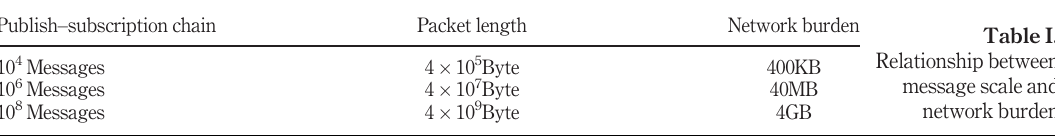
Table I. Relationship between message scale